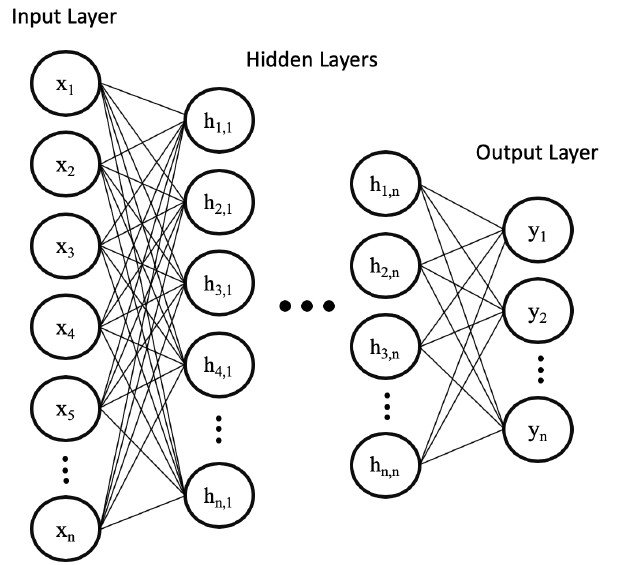
Figure 3. A deep feedforward neural network (DNN) similar to the perceptron has the input layer along with the output layer. However, the DNN has a large number of hidden layers and neuron